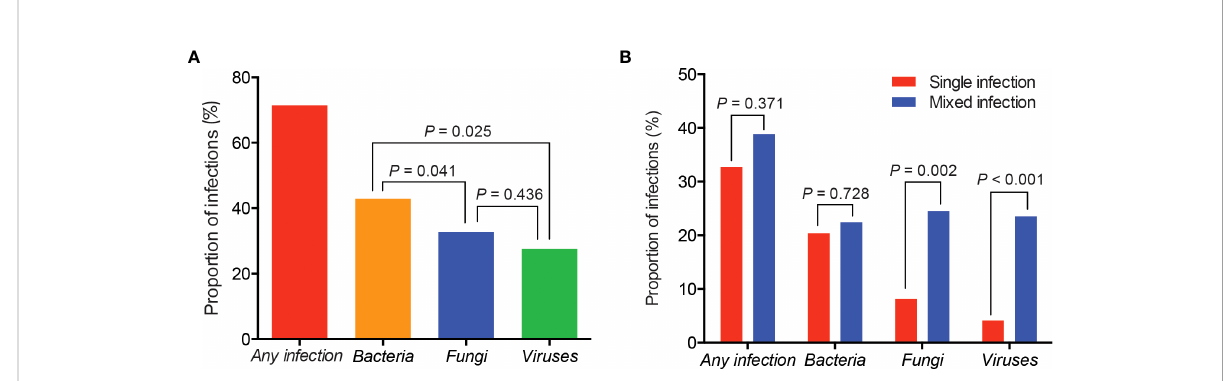
FIGURE 1 Proportions of different types of infections in patients with rheumatic diseases and diffuse pulmonary lesions. (A) Proportions of total, bacterial, fungal and viral infection events; (B) Proportions of single and mixed infection events.